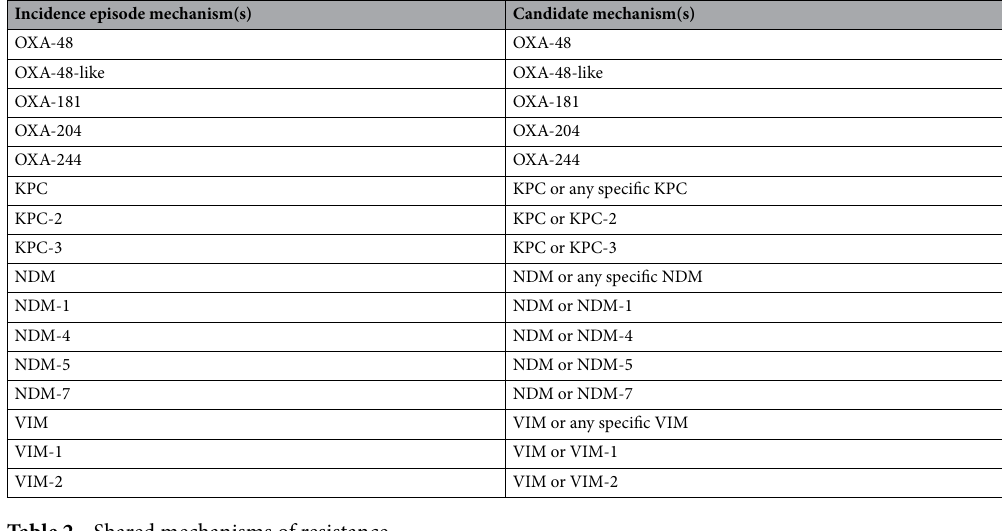
Table 2. Shared mechanisms of